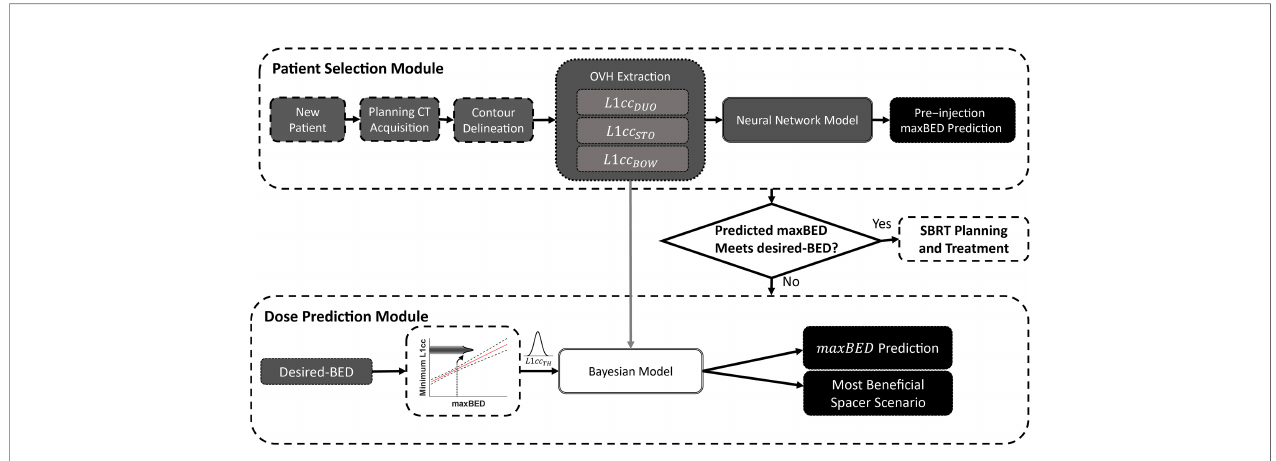
FIGURE 2 | The overview of the decision support system to predict the optimal location of the spacer and maximum achievable